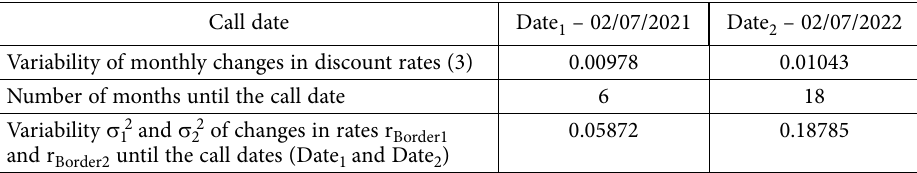
Table 4. Variability of changes in discount rates until the (Date 1 ) and (Date 2 )